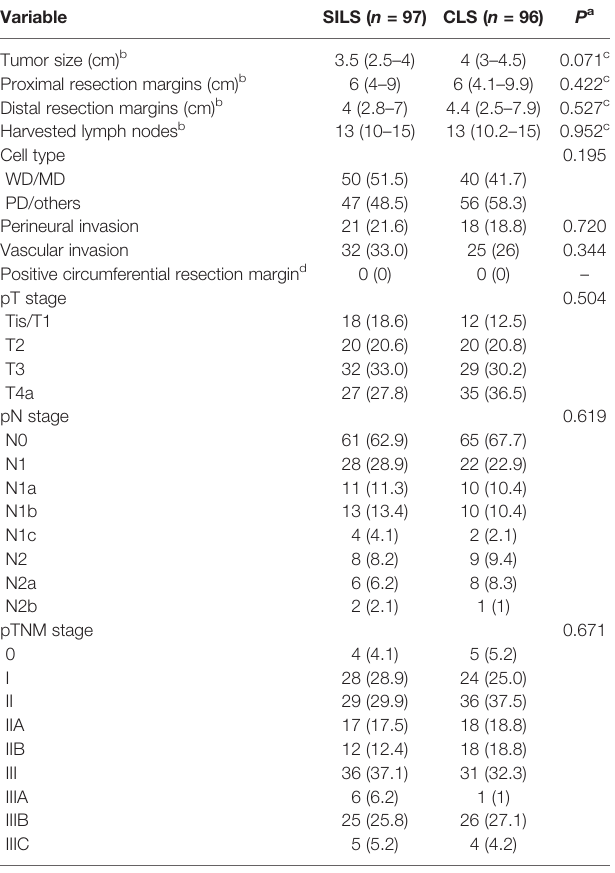
TABLE 4 | Pathologic